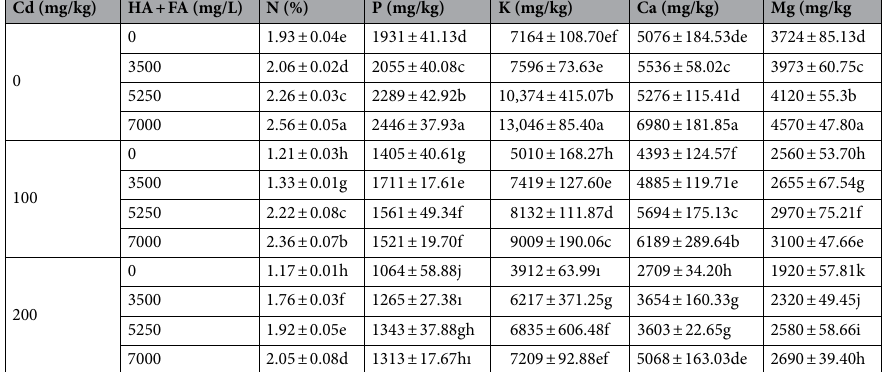
Table 4. Effect of cadmium and HA applications on macro element content of garden cress. The difference between the means indicated by different letters in the same column is statistically significant (Duncan multiple comparison test, P < 0.05).